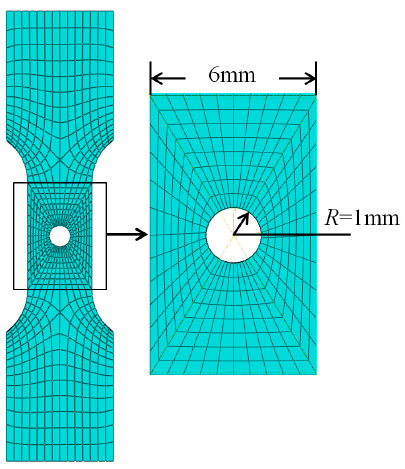
Figure 10. Finite element model of the plate with a center hole.